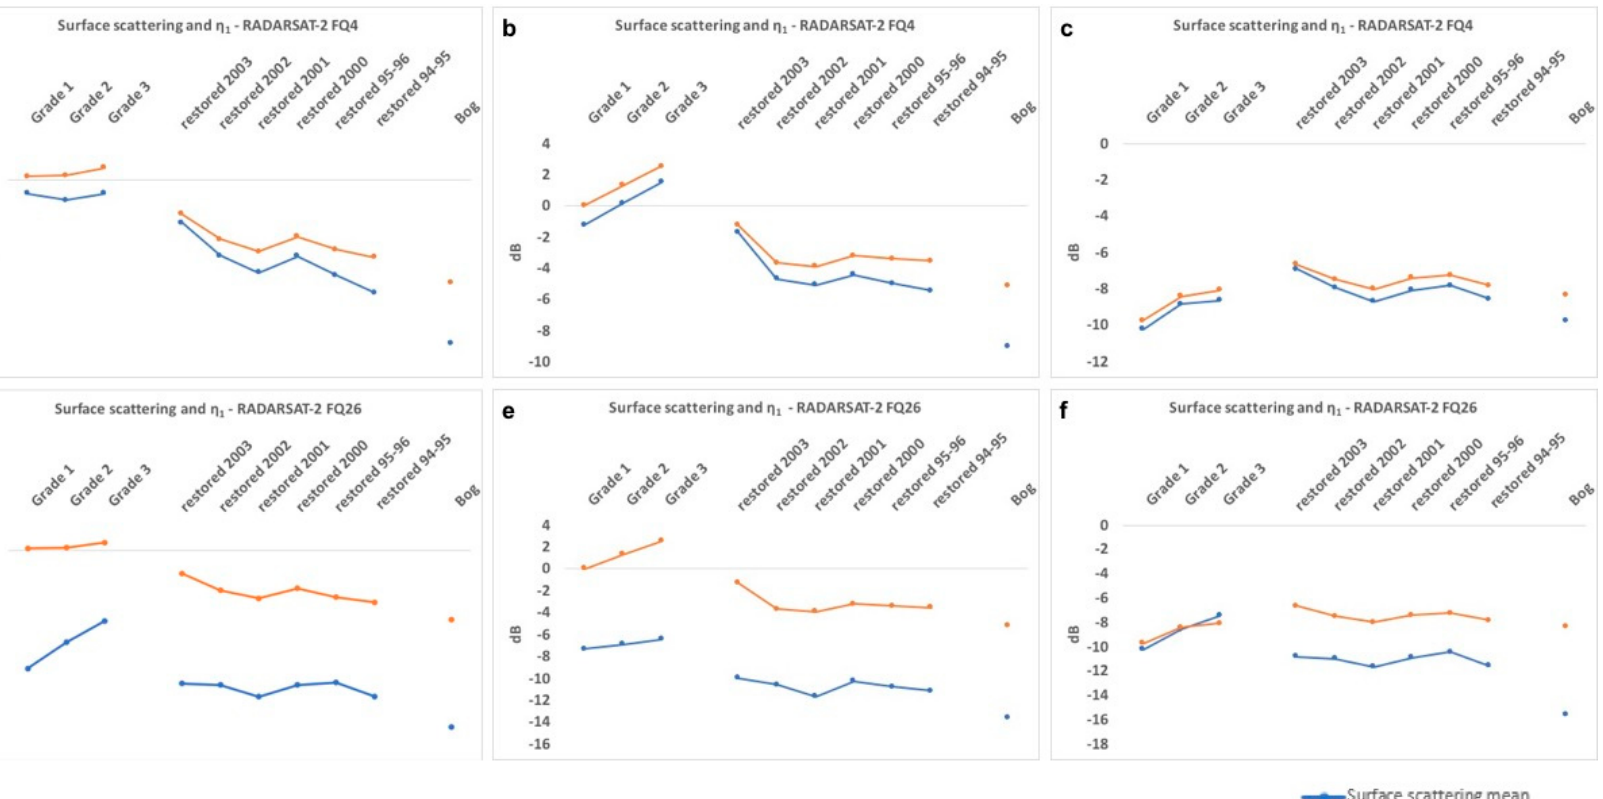
Figure 9. Comparison of dB values from the FD rough surface scattering and the ICTD η 1 for July 15 FQ4 ( a ), August 22 FQ4 ( b ), October 19 FQ4 ( c ), July 18 FQ26 ( d ), August 15 FQ26 ( e ), and October 22 FQ26 ( f ) 2015 RADARSAT-2 images.